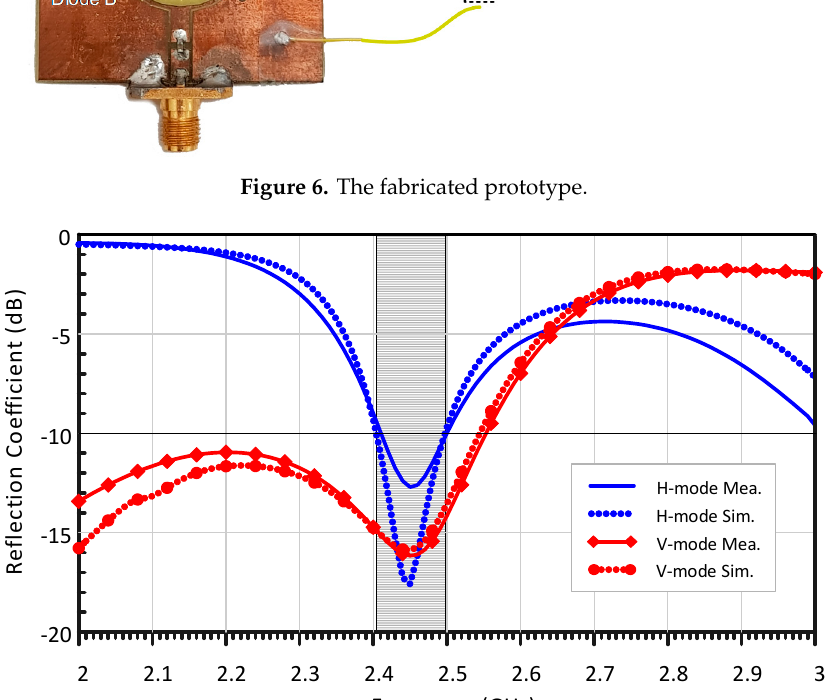
Figure 7. Measured and simulated reflection coefficient.